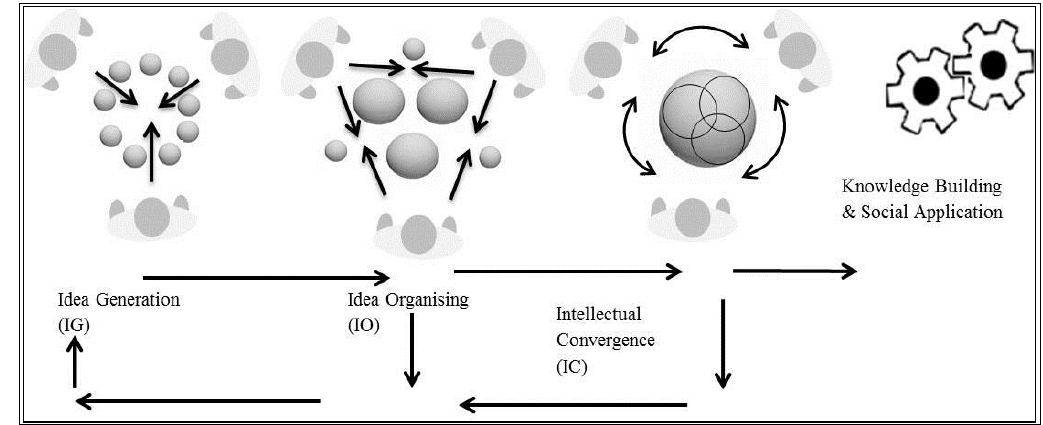
Figure 1 . Three intellectual phases of online collaborative learning (adapted from Harasim (2012,